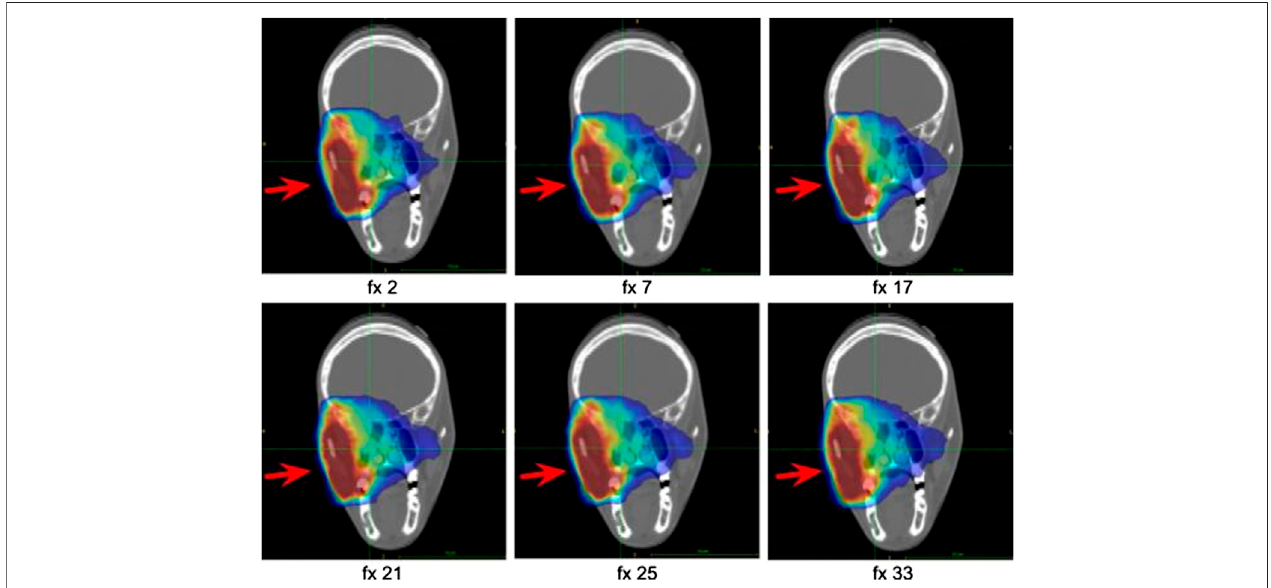
FIGURE 5 | Coronal sections at the isocenter of the activity images of patient 006P correspondingto six different fractions along the treatment course. The activity distribution is shown superimposed to the planning CT. The beam direction is identi fi ed by the red arrow.